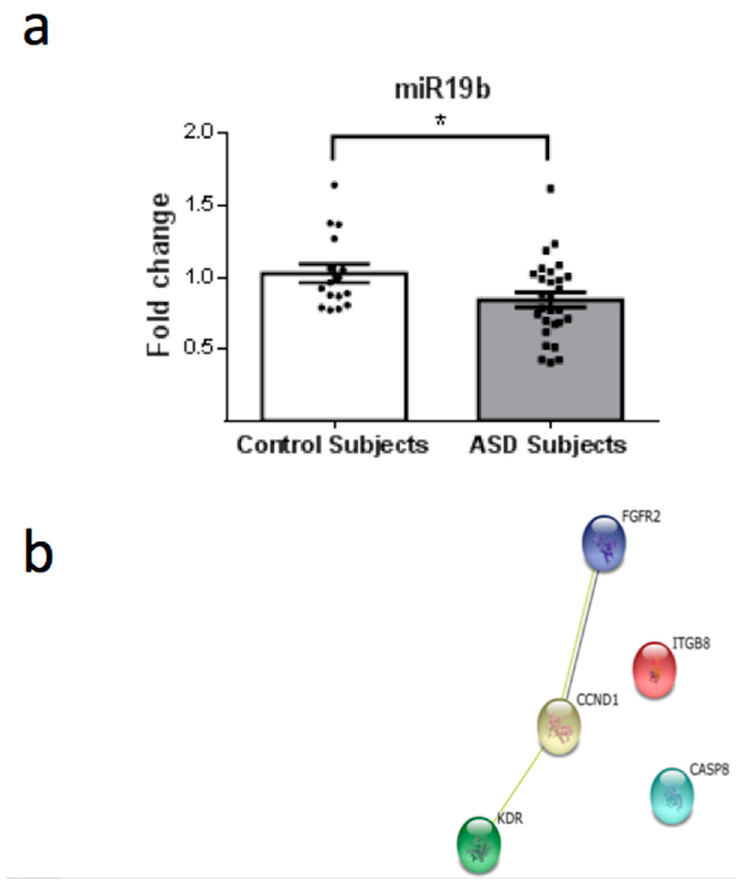
Figure 5. ( a ) Scatter plot of differential relative expression of miR19b in peripheral blood of ASD subjects compared to control subjects. Results expressed as mean ± standard error. t -Test analysis; * p < 0.05. ( b ) mRNA validates targets for miR19b selected in miRBase and respective proteins clusters that can be involved in ASD. Protein involved in cell cycle: CCND1 (cyclin D1). Proteins associated with cytoskeleton: ITGB8 (integrin, beta 8); KDR (kinase insert domain receptor). Others: CASP8 (caspase 8); FGFR2 (fibroblast growth factor receptor 2).